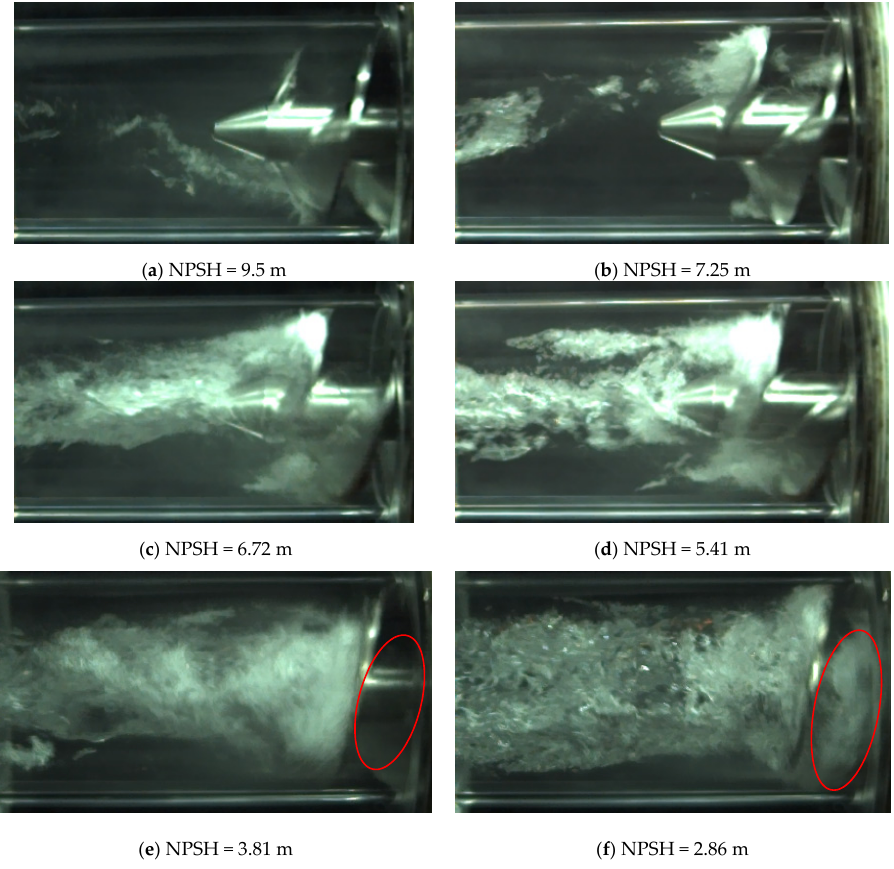
Figure 10. Cavitation evolution in the inducer under Q = 0.27 Q d . According to Figure 10, bubbles in the inlet pipe increased as NPSH decreased, and the cavitation evolution in the inducer at 0.27 Q d was different from the large flow